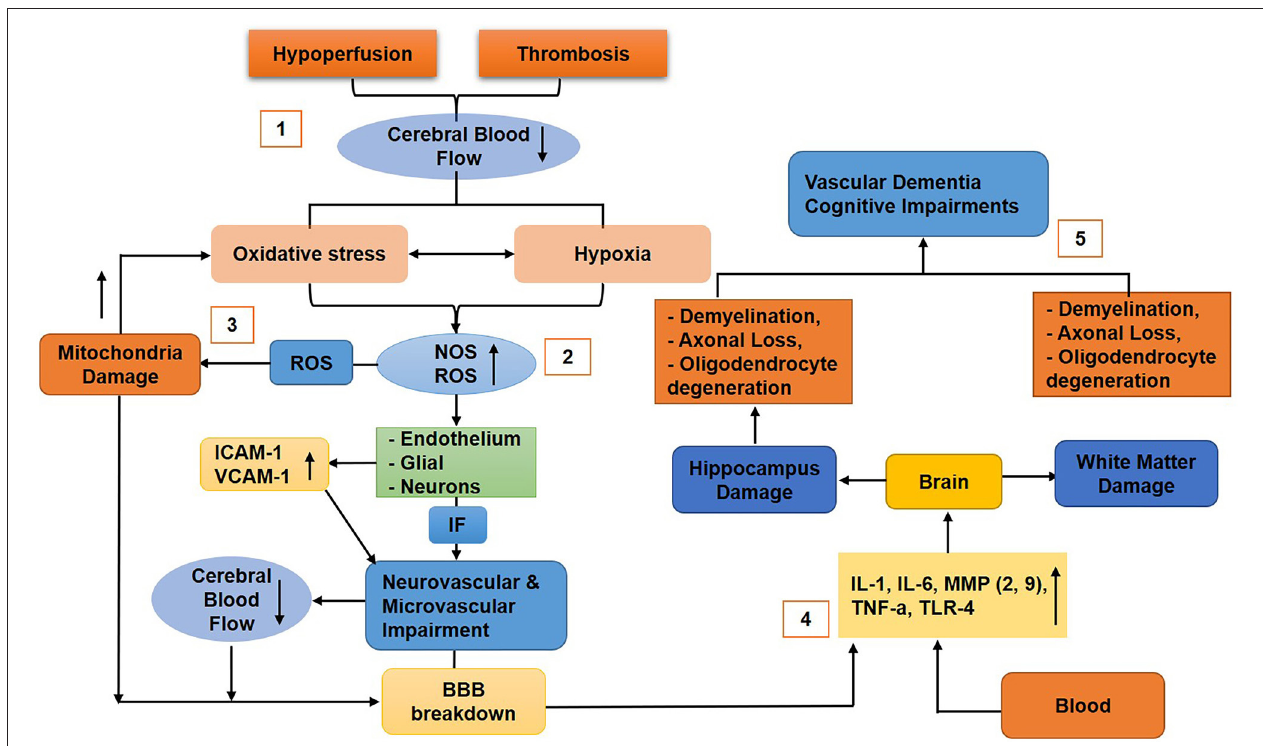
FIGURE 6 | Diagram that shows the molecular mechanism of blood–brain barrier (BBB) breakdown in vascular dementia. (1) Hypoperfusion and thrombosis cause reduced cerebral blood flow (CBF), thus generating oxidative stress and hypoxia (2), which upregulate nitric oxide and reactive oxygen species (ROS) that stimulate the endothelial (ICAM-1, VCAM-1 upregulated), glial, and neuronal cells to release inflammatory factors that cause neurovascular unit (NVU) impairment and reduce CBF and BBB disruption. (3) ROS damage mitochondria of the BBB cells that will further upregulate oxidative stress, resulting in BBB impairments. (4) Cytokines, chemokines, toxins, and other inflammatory molecules infiltrate the brain and cause damage to the hippocampus and white matter (5) associated with neuronal loss, vascular dementia, and cognitive impairments.